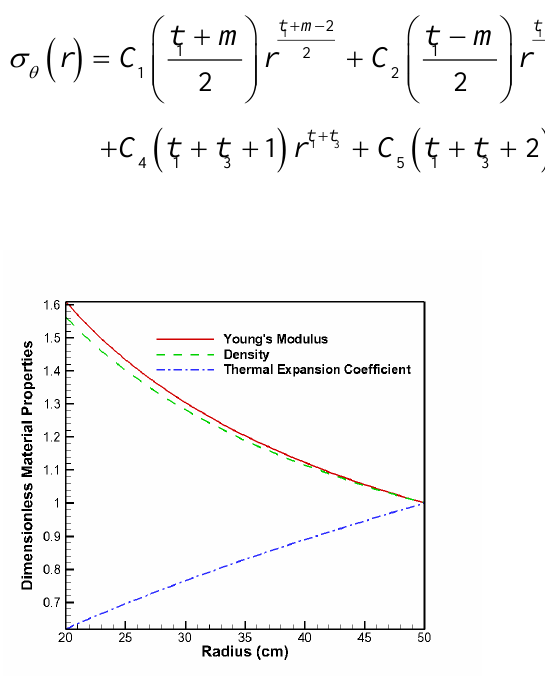
Figure 1. Material properties of FG disc Figure 2. Temperature distribution for FG